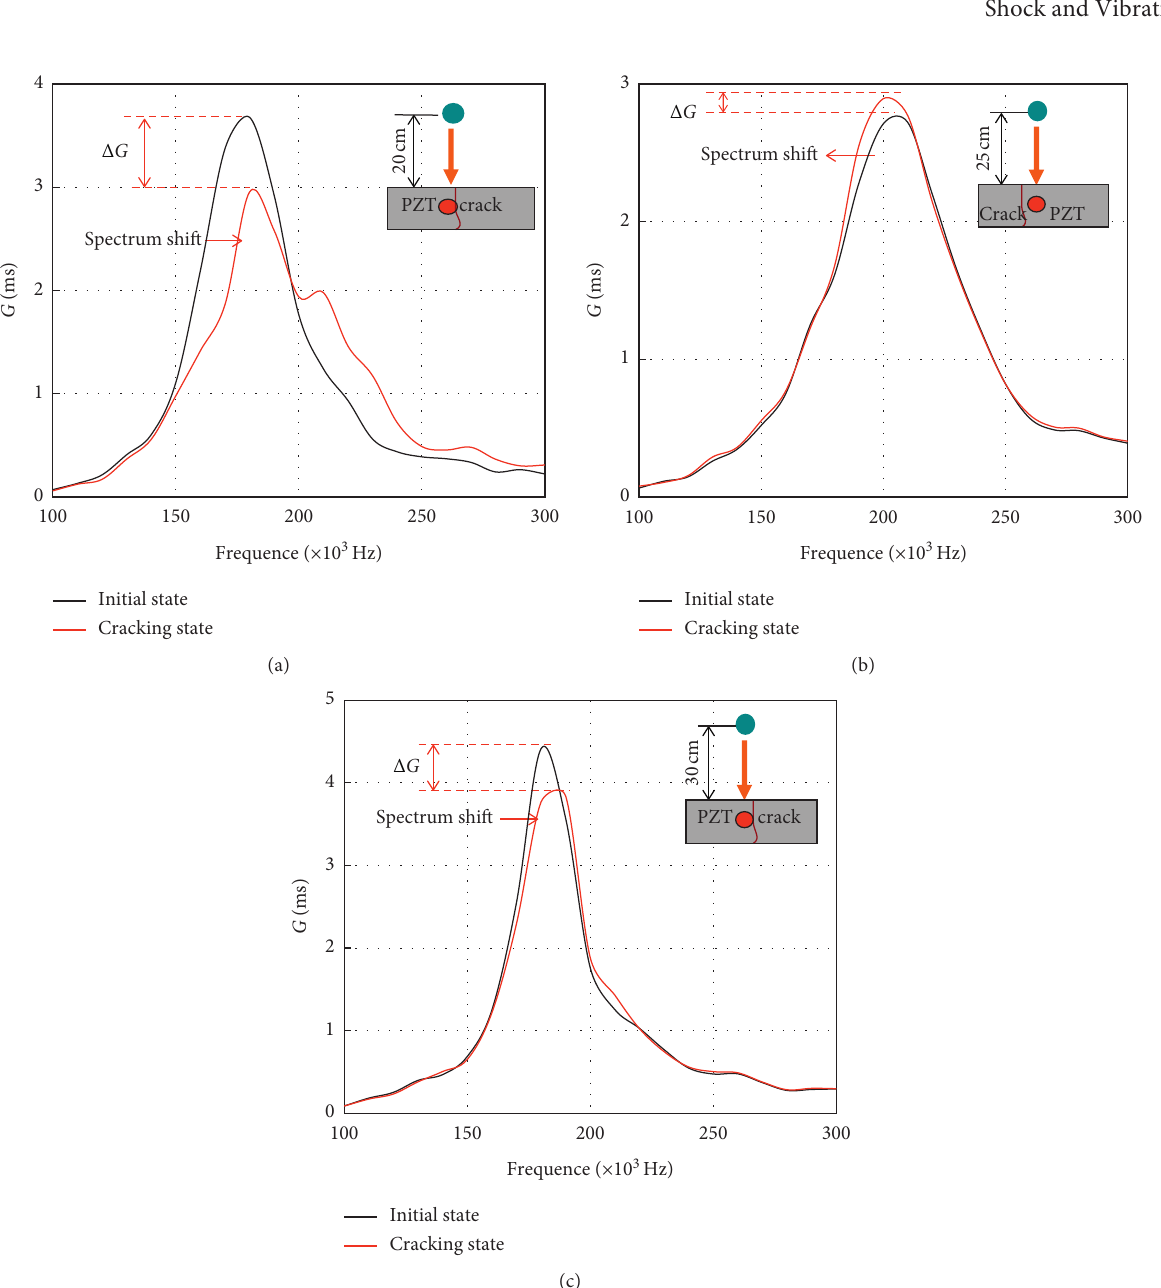
Figure 7: Conductance signal test results in the initial and failure states of the samples: (a) 20cm; (b) 25cm; (c)